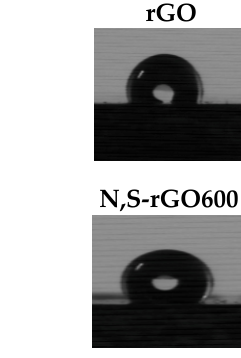
Figure 4. Atomic Force Microscopy (AFM) images for graphene coatings.